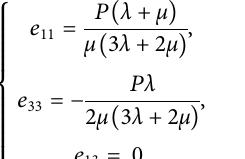
Frontiers in Earth Science |